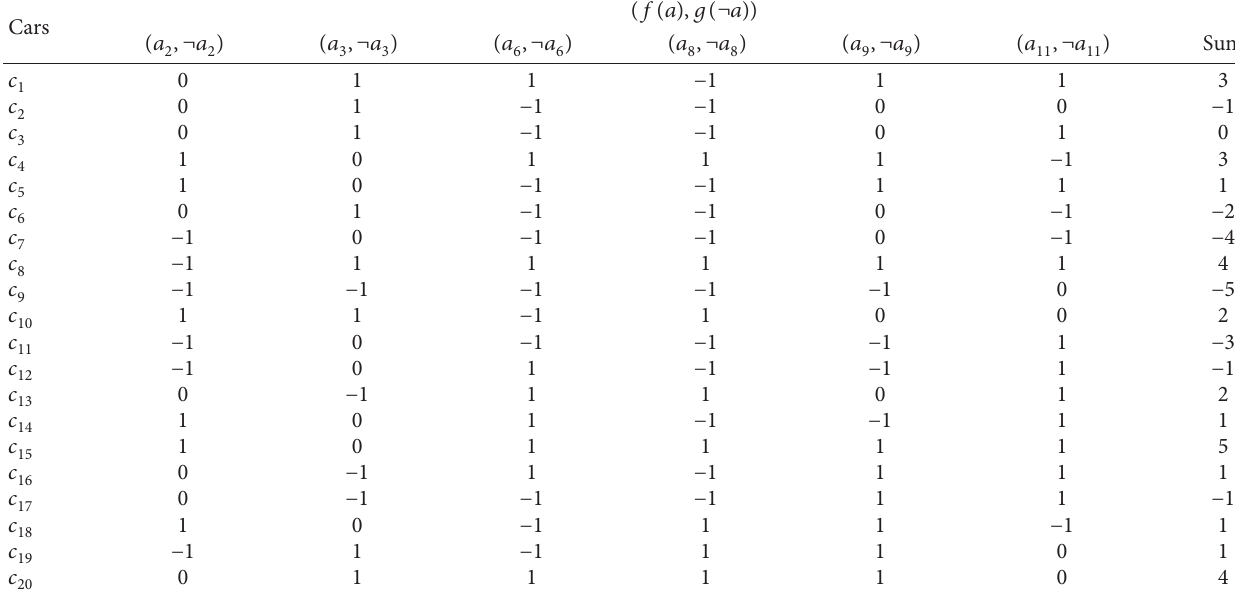
Table 3: Values of all components of the favorite bipolar soft sets ( f, g,E )